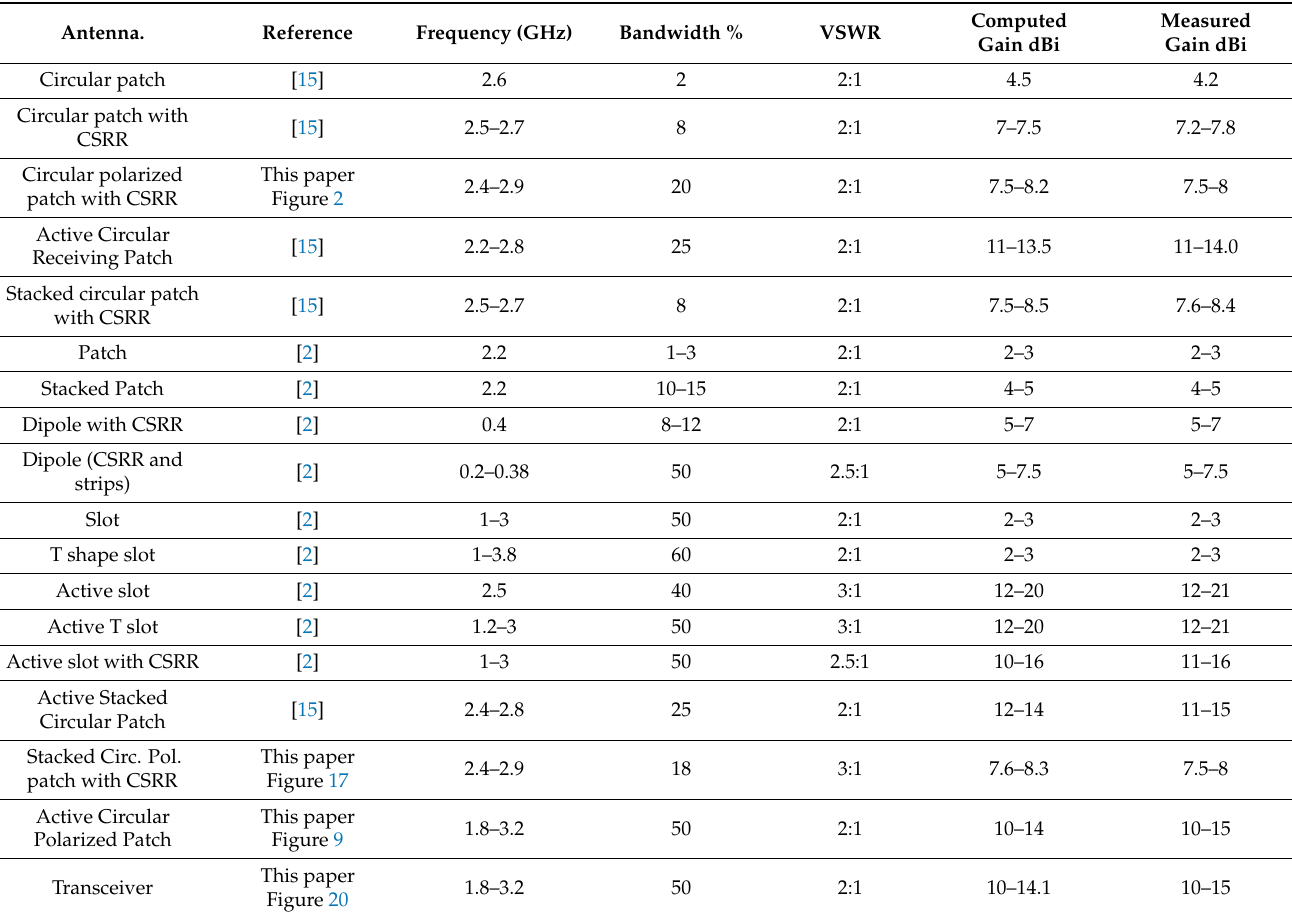
Table 11. Comparison of electrical performance of wearable printed antennas [2,15].